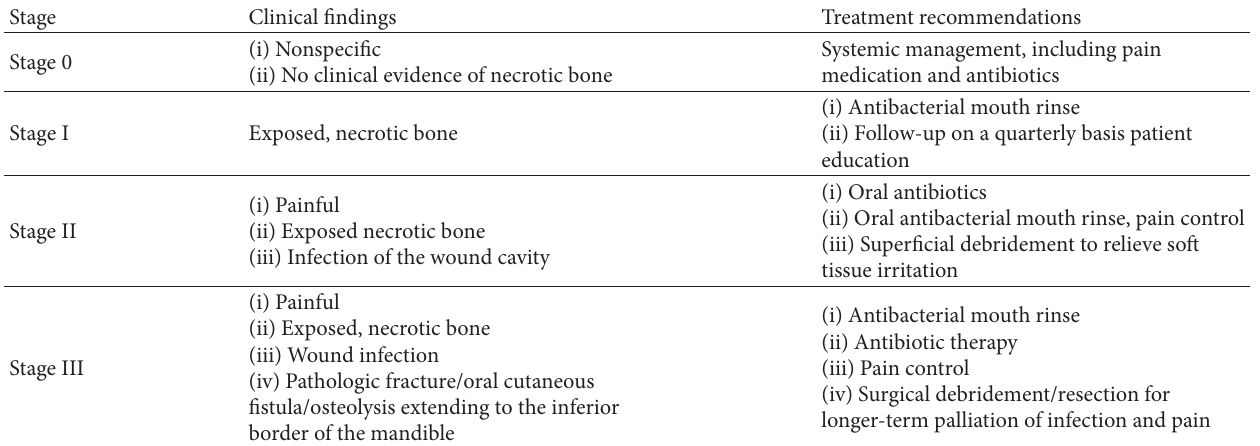
Table 1: AAOMS staging system of